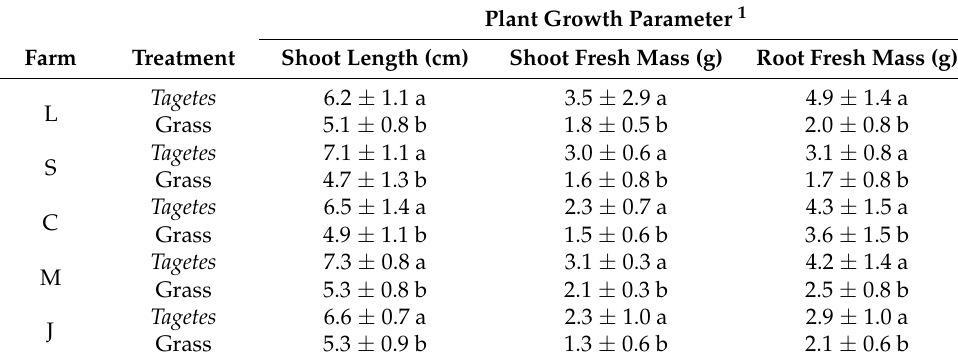
Table 5. Vegetative growth of apple M26 plants in pots inoculated with nematodes extracted from ARD soils pre-cultured with Tagetes or